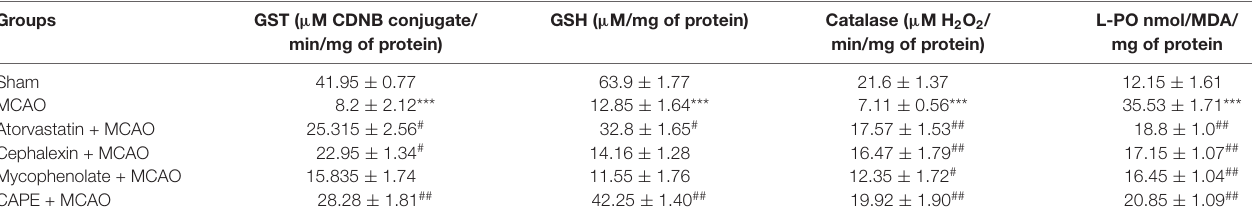
TABLE 5 | Effect of atorvastatin, mycophenolate, cephalexin, and CAPE on oxidative enzymes in the striatum.